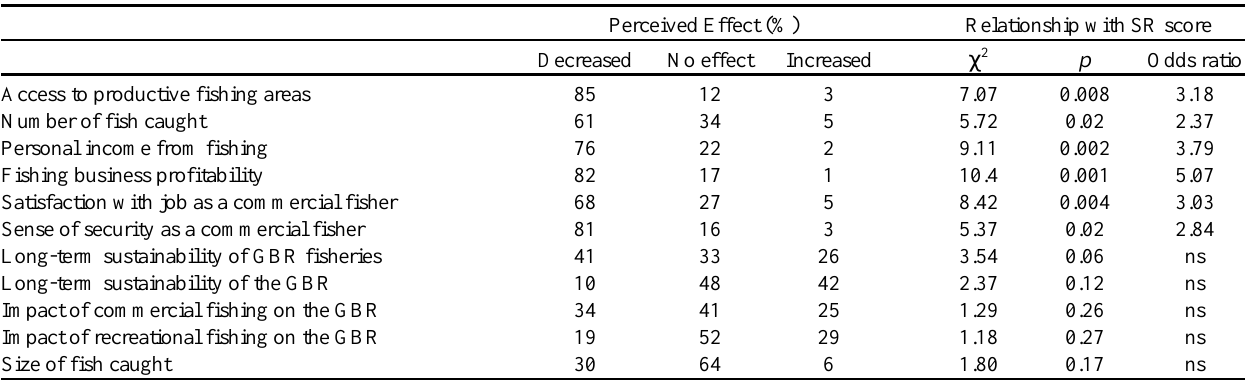
Table 4. Queensland commercial fishers’ perceptions of the impacts of the 2004 Great Barrier Reef zoning plan on various aspects of their fishing business and fishing activity, and results of proportional odds logistic regression models testing the relationship between perceived impact and social resilience (SR)